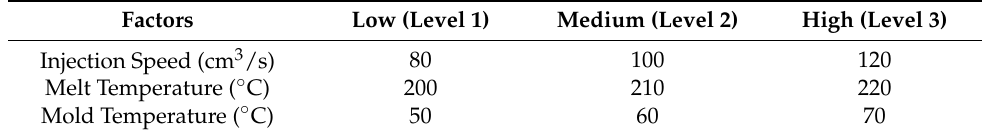
Table 1. Factor levels for the experiment.